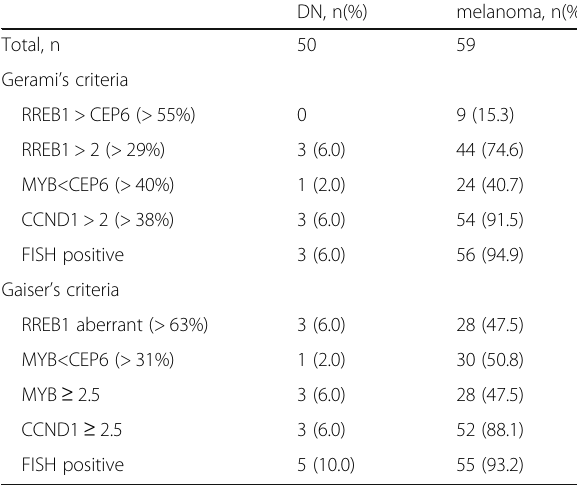
Table 2 Number and percentage of cases meeting each diagnostic criterion of Gerami and Gaiser for dysplastic nevi and early-stage acral and cutaneous melanomas